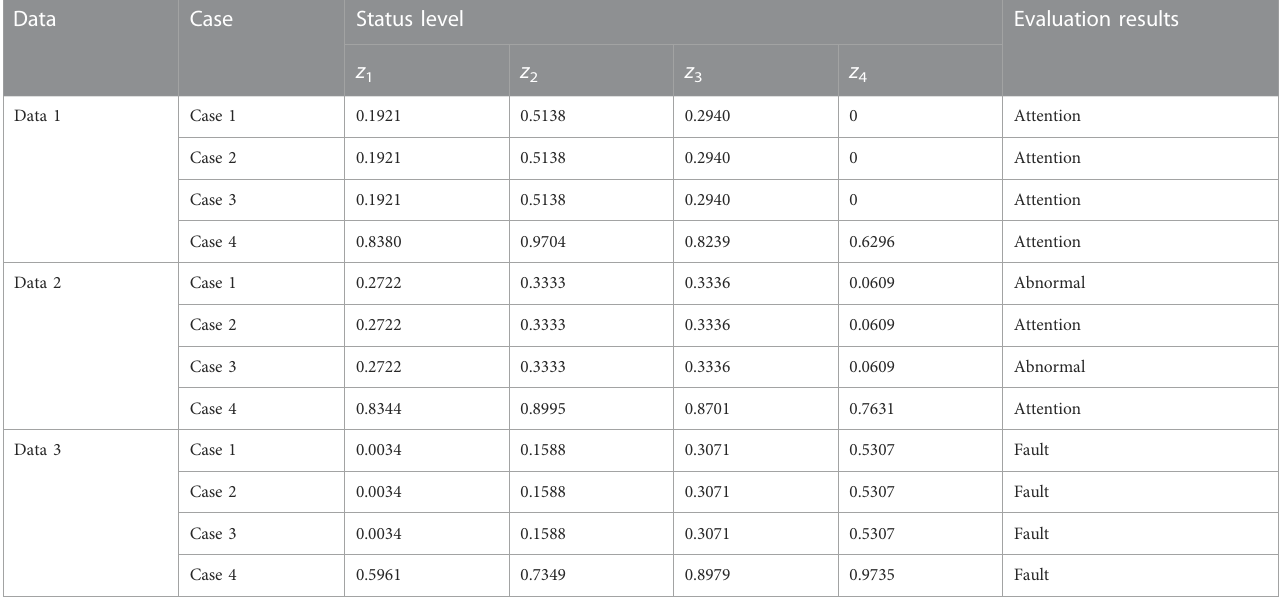
TABLE 6 Comparison of the evaluation results in different